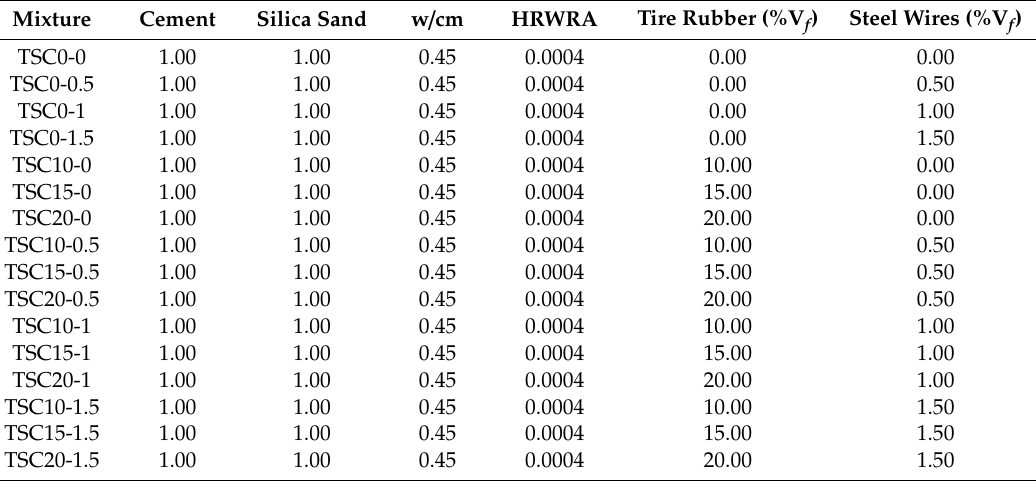
Table 2. Mixture proportions of the TSC mixtures.